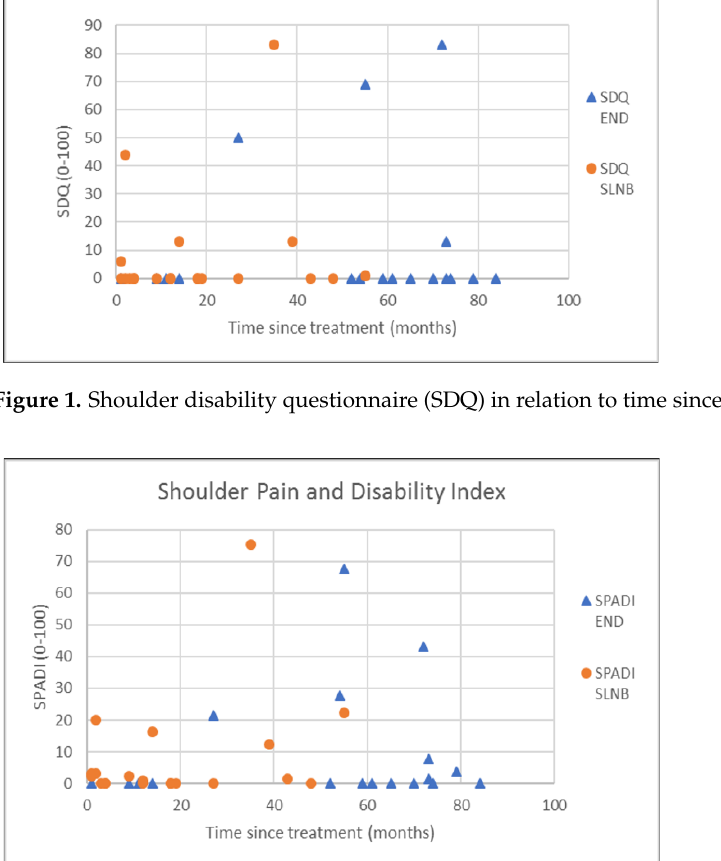
Figure 2. Shoulder pain and disability index (SPADI) in relation to time since treatment.